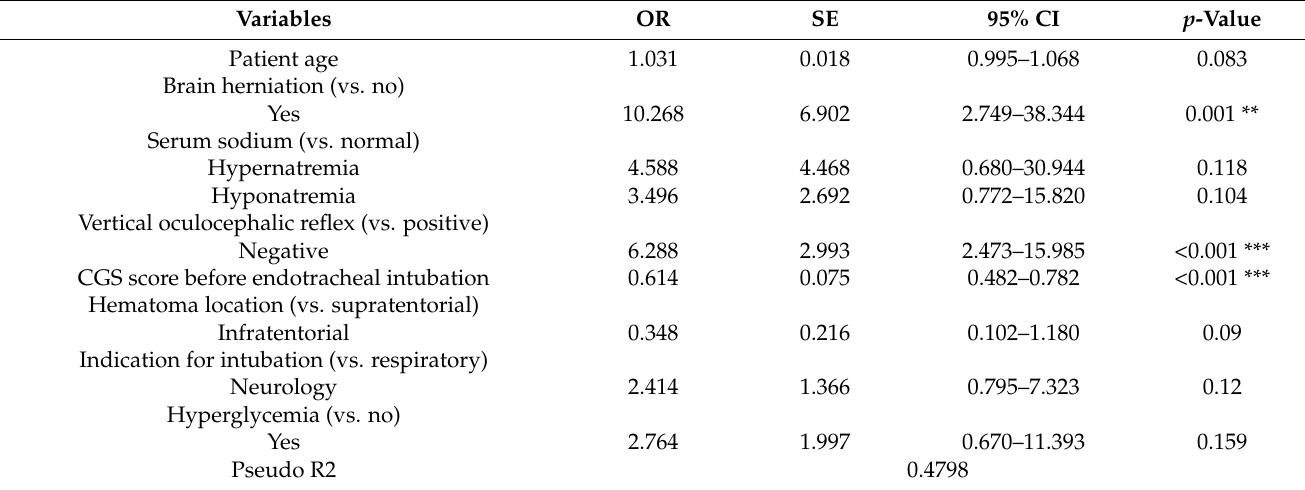
Table 6. A reduced model including the mortality risk factors for patients with intracranial hemorrhage undergoing endotracheal intubation: multivariate logistic regression